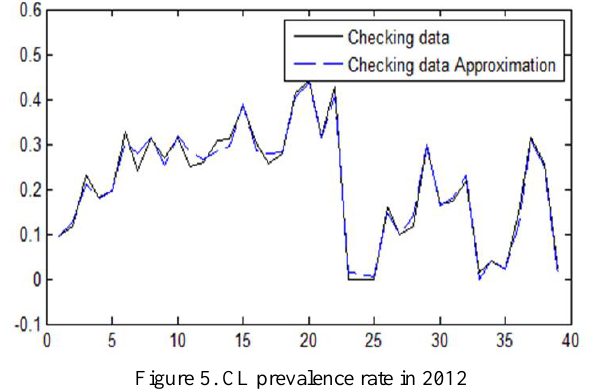
Figure 5. CL prevalence rate in 2012 After the first three stages of network design, training, and testing, raster maps of 100 pixels are re-generated for cities of Dehloran, Ilam, and Mehran for factors of temperature, humidity, precipitation, altitude, and vegetation index. Model output values and CL prevalence rate in each pixel is shown in Figure (6) as CL risk